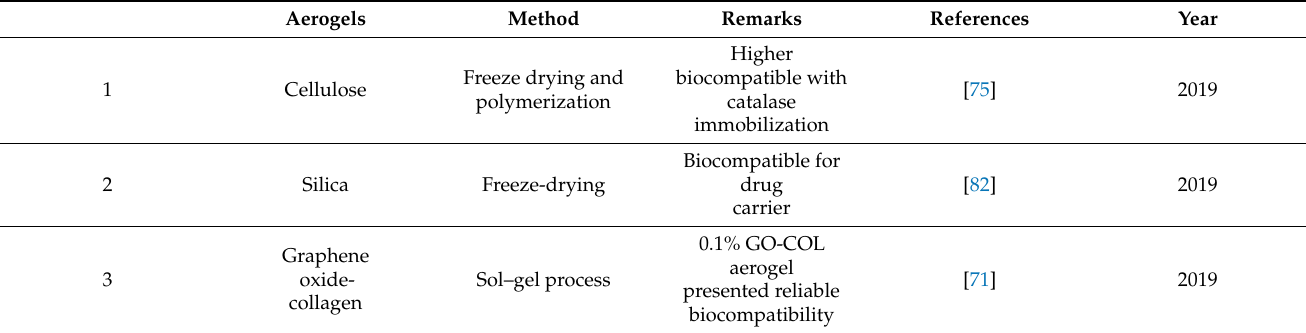
Table 2. Summary of studies on compatibility of aerogels for biomedical